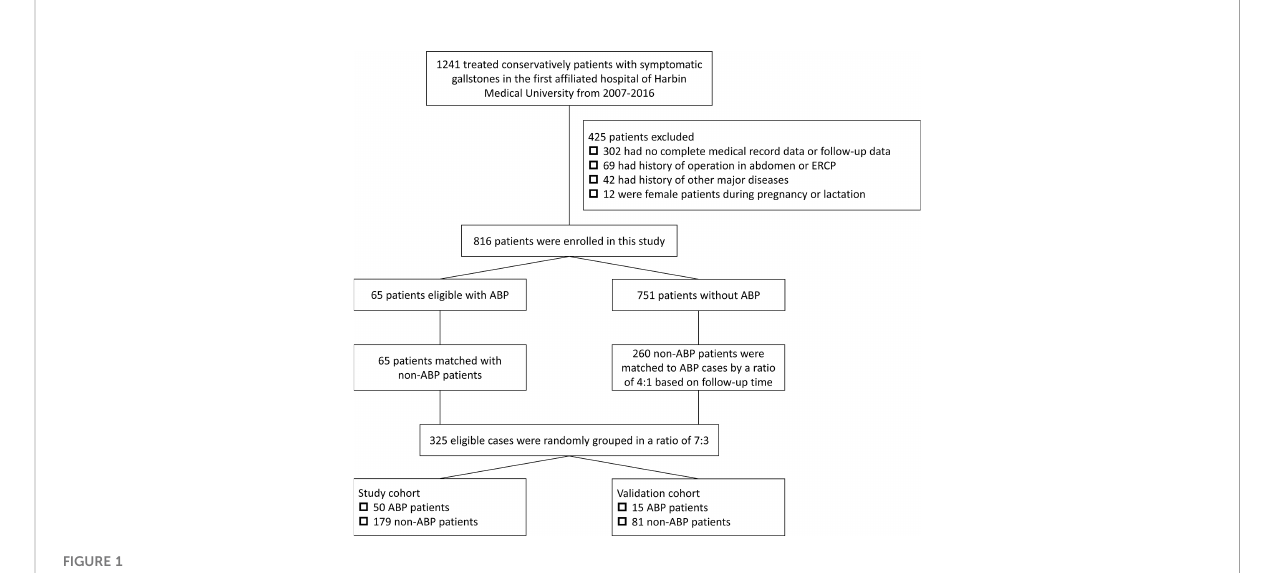
FIGURE 1 Flow chart of the